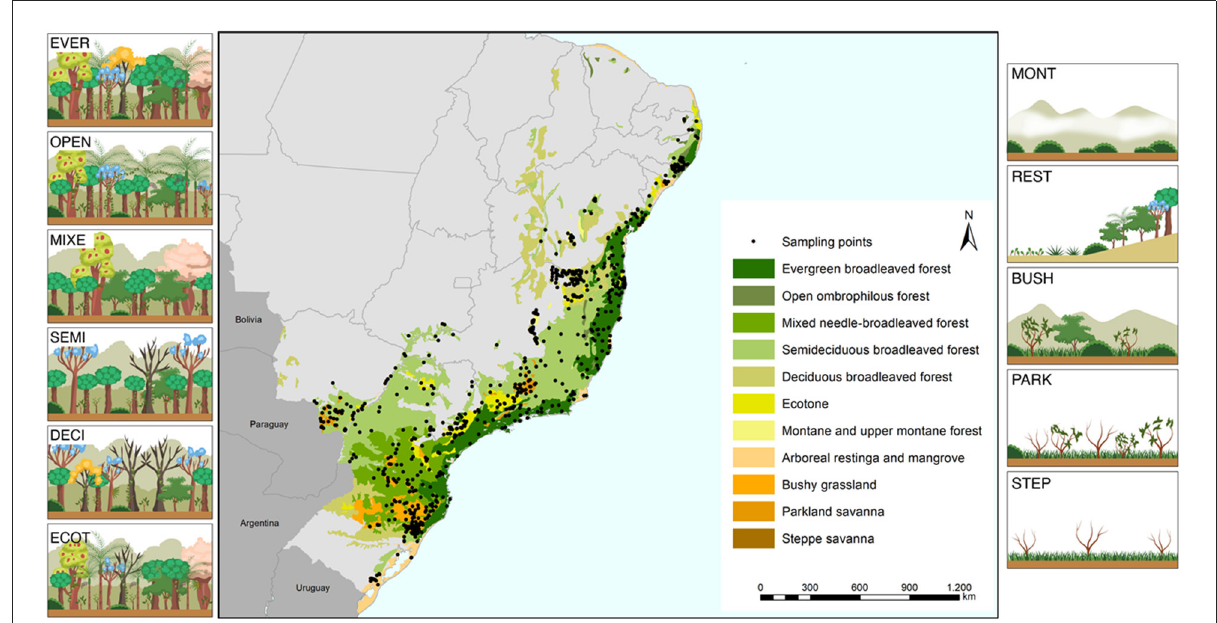
FIGURE1 Spatial distribution of the 11 ecoregions of the Atlantic Forest and the location of the points sampled for this study. REST, Arboreal restinga and mangrove; BUSH, Bushy grassland; DECI, Deciduous broadleaved forest; ECOT, Ecotone; EVER, Evergreen broadleaved forest; MIXE, Mixed needle-broadleaved forest; MONT, Montane and upper montane forest; OPEN, Open ombrophilous forest; PARK, Parkland savanna; SEMI, Semideciduous broadleaved forest; STEP, Steppe